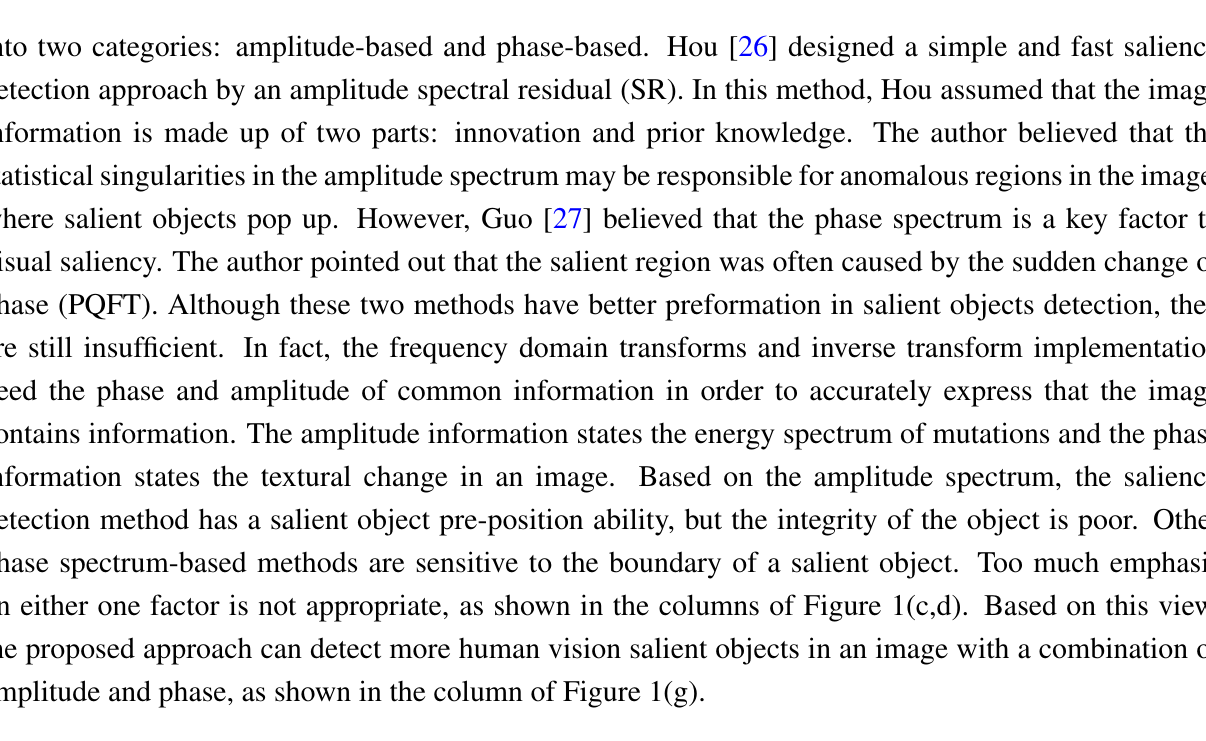
Figure 1. Comparison of five saliency perception algorithms. ( a ) Raw images, Bird: color higher contrast, Dandelion: texture higher contrast; ( b ) saliency maps of Itti’s method [13]; ( c ) saliency maps of Hou’s method (spectral residual (SR)) [26]; ( d ) saliency maps of Guo’s method phase spectrum of quaternion Fourier transform (PQFT) [27]; ( e ) Saliency maps of quaternion discrete cosine transform (QDCT) [38]; ( f ) saliency maps of HFT [34]; ( g ) saliency maps by the proposed saliency perception method (hypercomplex spatiotemporal spectral contrast